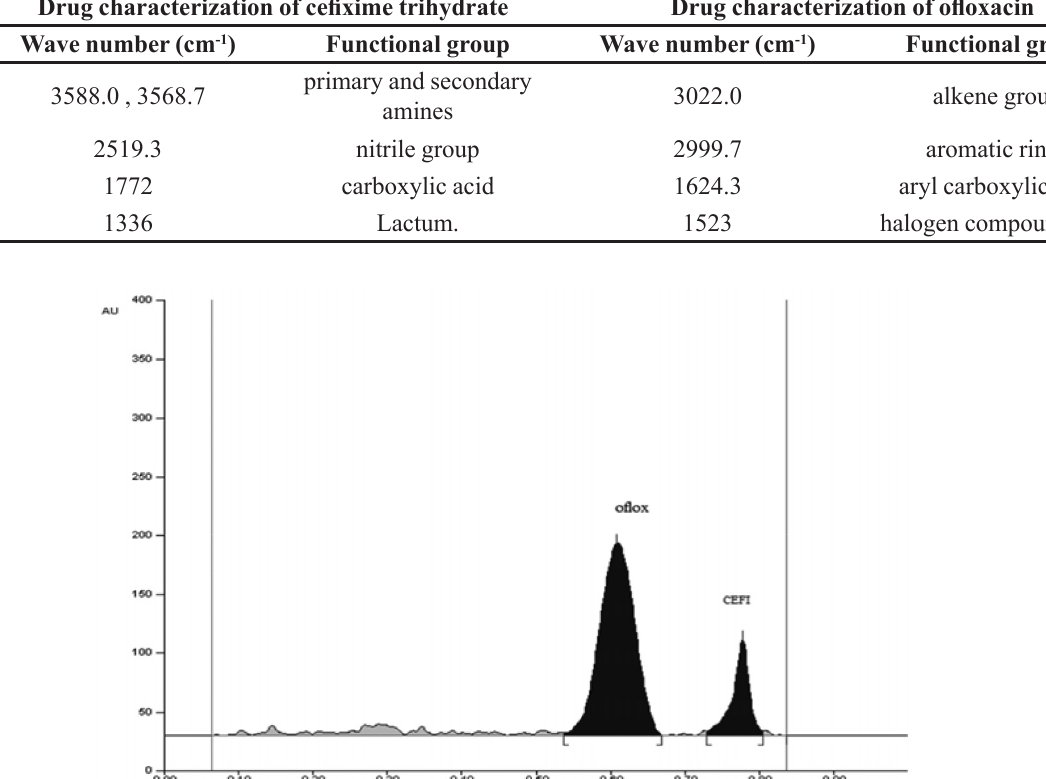
FIGURE 3 - Representative densitogram of mixed standard solution of ofloxacin (200 ng/band, Rf = 0.61 ± 0.10) and cefixime trihydrate (200 ng/band, Rf = 0.78 ± 0.12).